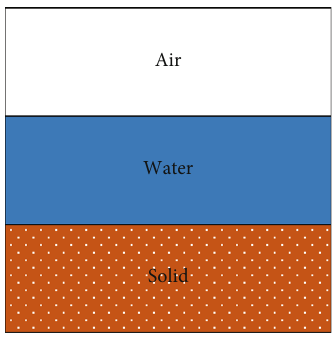
Figure 1: Three-phase sketch of SRM.